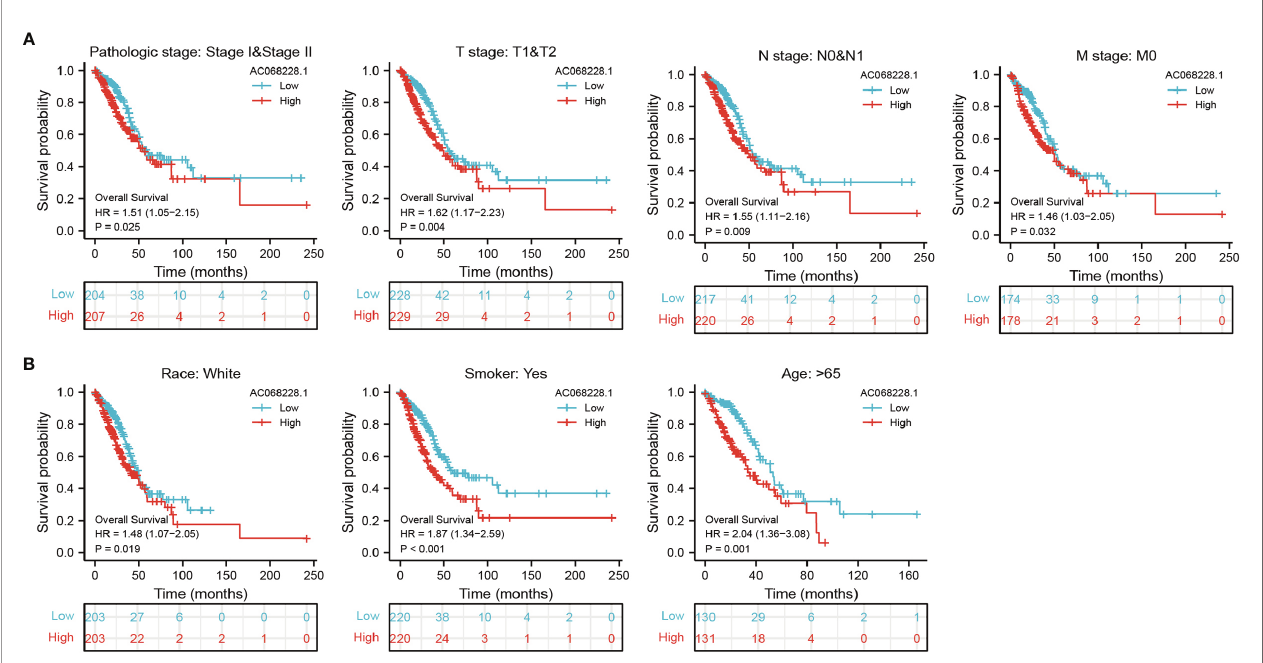
FIGURE 4 | Kaplan – Meier survival analyses for prognostic values of AC068228.1 in different subgroups strati fi ed by clinical features. (A, B) Kaplan – Meier curves for overall survival of AC068228.1 in subgroups including stage I-II, T1-T2, N0-N1, M0, Race, white, age>65years, and Smoker in TCGA-LUAD cohort.